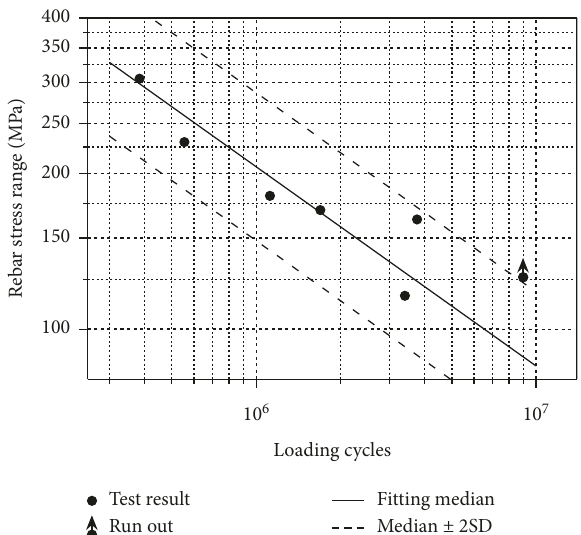
Figure 11: S-N data and corresponding linear fitting of this test.